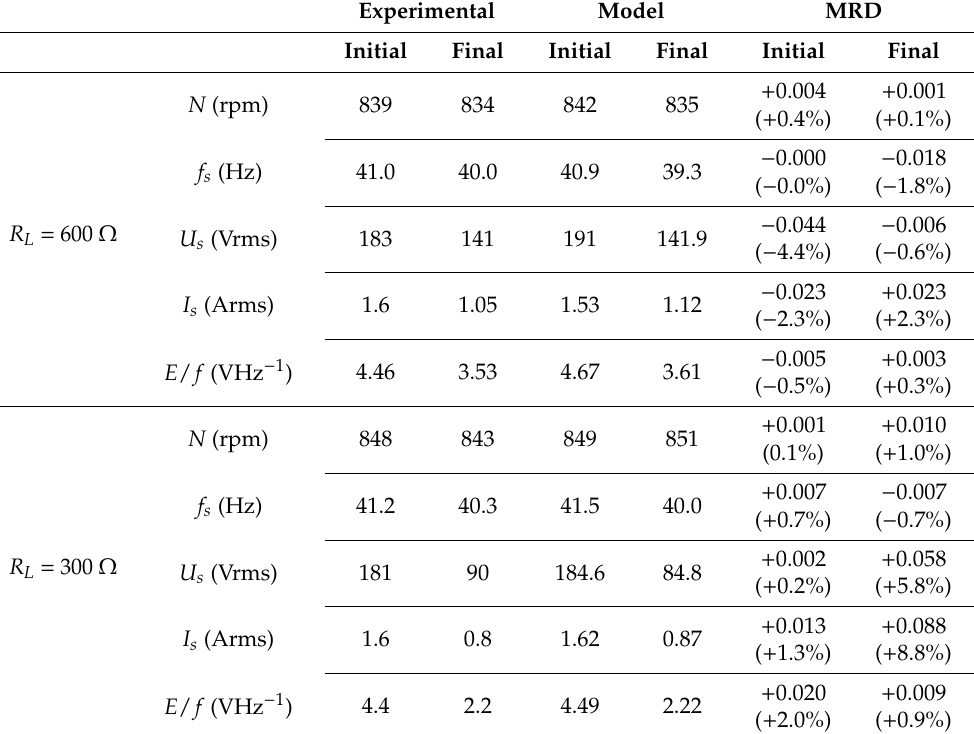
Table 4. Comparison between steady-state experimental and model’s results after the application of resistive loads. Experimental Model